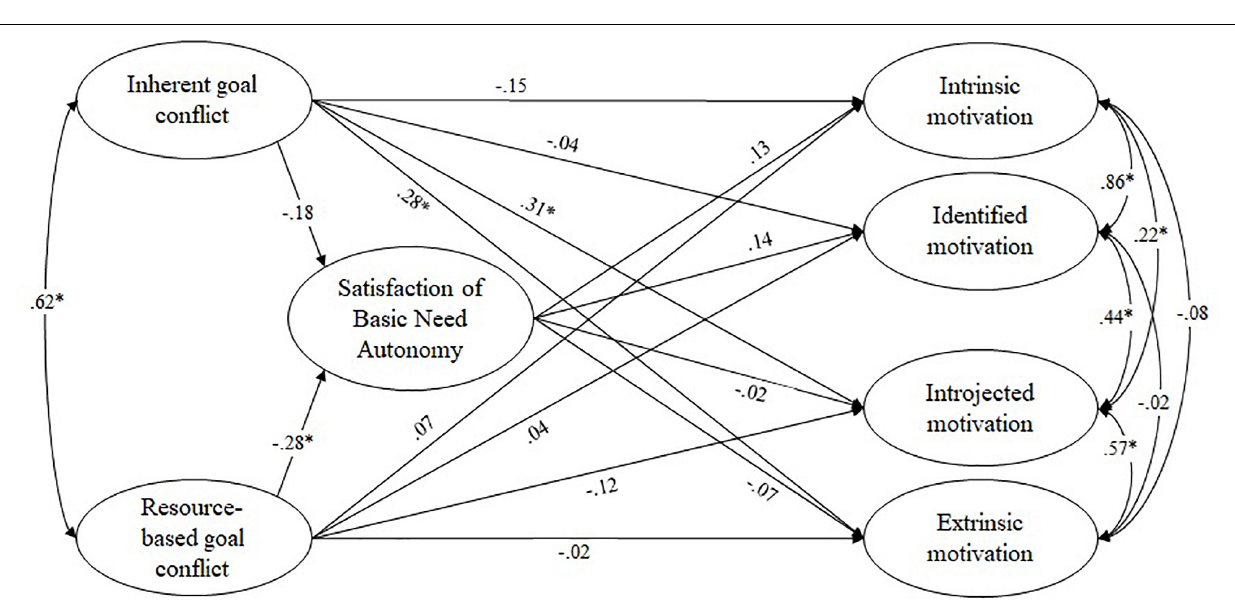
Frontiers in Psychology |